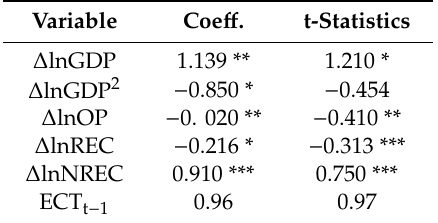
Table 7. Short-run coe ffi cients estimates of ARDL. Variable Coe ff